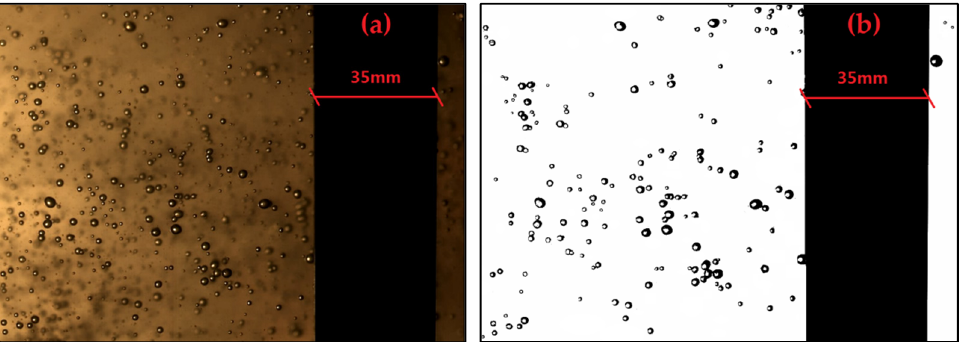
Figure 2. Captured and processed sample images of bubbles. ( a ) Original image of bubbles. ( b ) Processed image of bubbles’ contours.